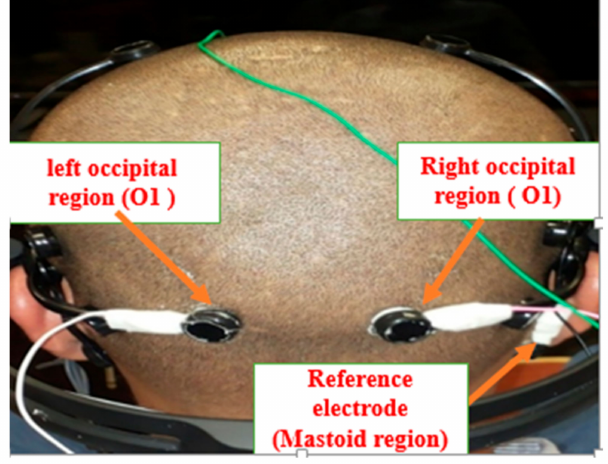
Figure 2. Electroencephalogram (EEG) electrodes